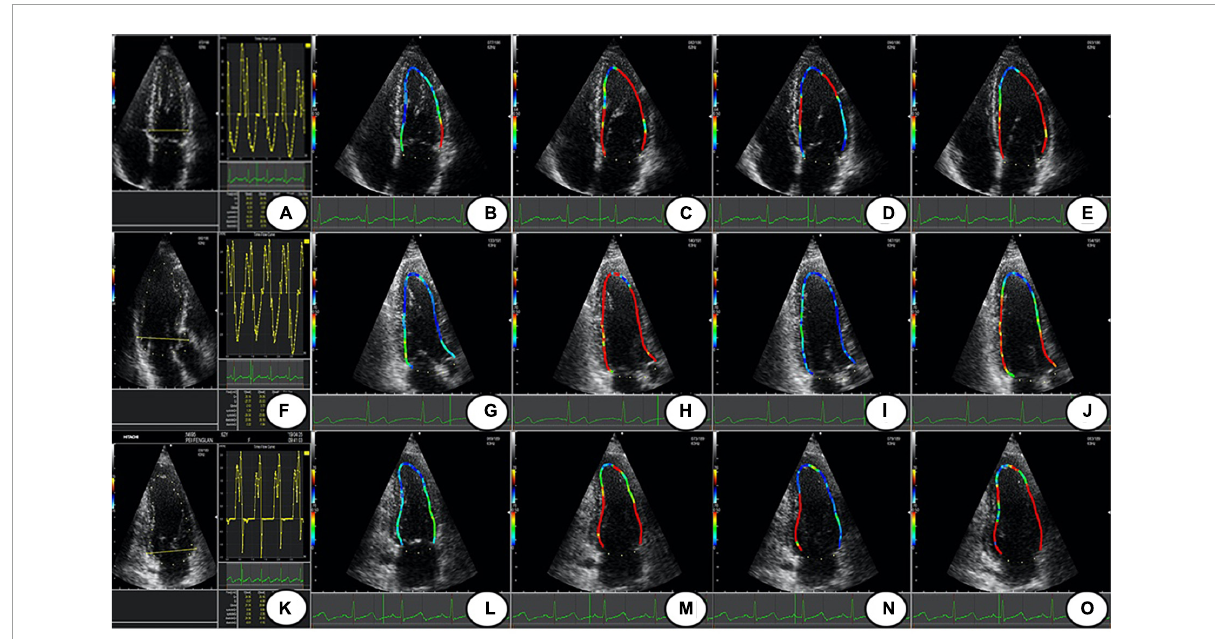
FIGURE1 The LV WSS of Apical 4 C, 3C, and 2C; (A,F,K) are the time-flow curves of Apical 4C, 3C, and 2C. (B–E) The LV WSS of Apical 4C in P1–P4; (G–J) the LV WSS of Apical 3C in P1–P4; (L–O) the LV WSS of Apical 2C in P1–P4. Apical 4C, apical 4-chamber; Apical 3C, apical 3-chamber; Apical 2C, apical 2-chamber; P1, isovolumic diastolic period; P2, rapid filling period; P3, slow filling period; P4, atrial contraction period; LV WSS, left ventricular wall shear stress.